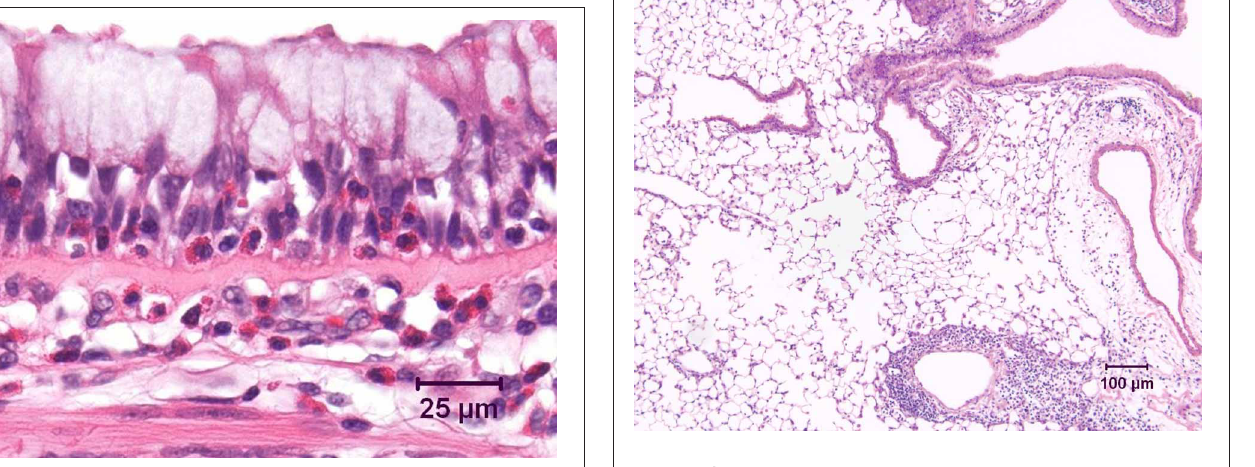
FIGURE 1 | Bronchus from an asthmatic patient, demonstrating numerous eosinophils, both within the airway epithelium and in the underlying lamina propria. Note the marked goblet cell change in the epithelium and the prominent zone of subepithelial fibrosis. Hematoxylin and eosin.